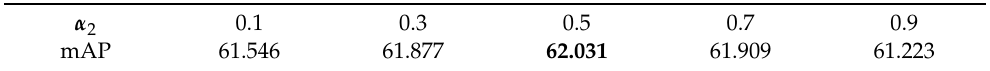
Table 2. Test results of different α 2 on the DOTA validation dataset ( λ has been fixed to 1.25, and α 3 has been fixed to 0.5 temporarily).